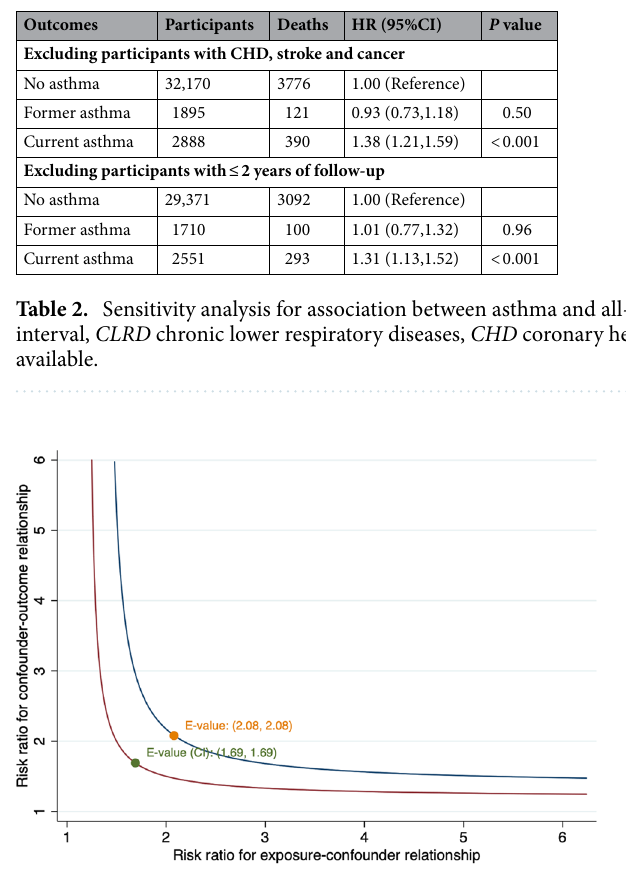
Figure 5. Value of the joint minimum strength of association on the risk ratio scale that an unmeasured confounder must have with the exposure and the outcome to fully explain away an observed current asthma— all-cause mortality